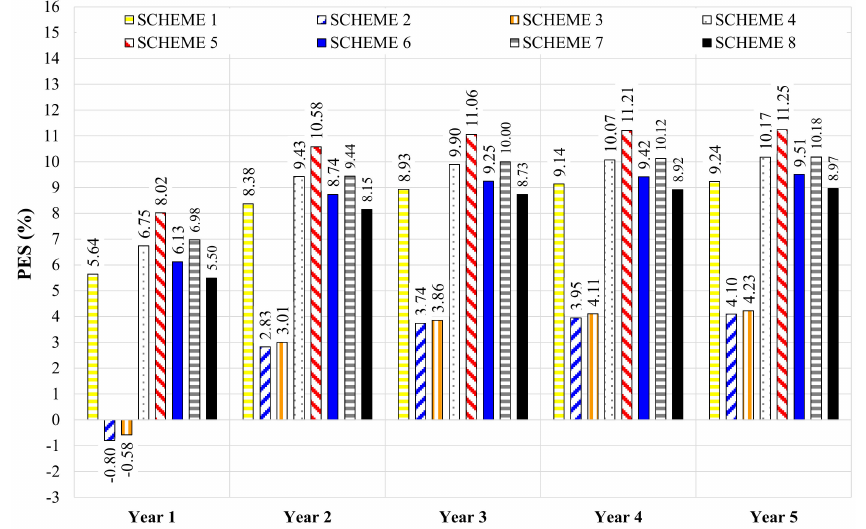
Figure 4. PES upon varying the time as a function of the system configuration.